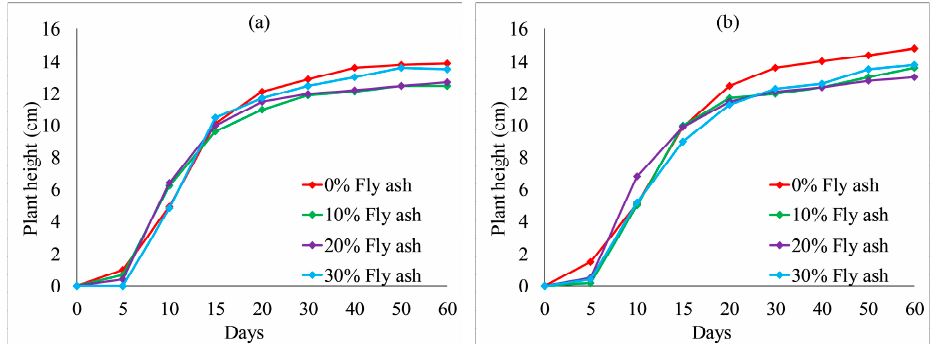
Figure 12. Ryegrass height relative to fly ash content combined with: ( a ) 5% KW fertilizer content; ( b ) 10% KW fertilizer content.